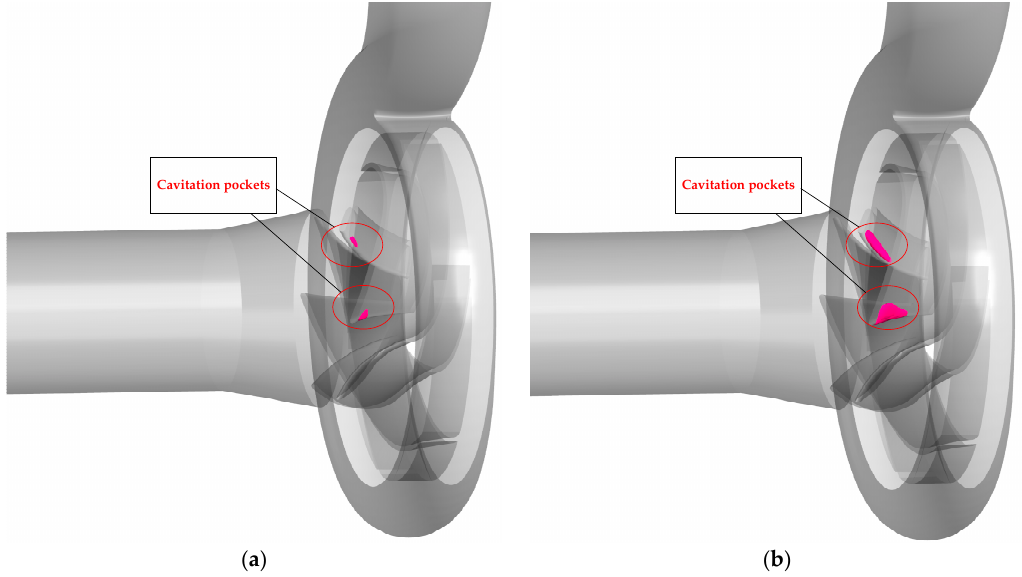
Figure 9. The distributions of cavitation pockets under different flow rates. ( a) 62 m 3 /h, 1.22 Q d ; ( b) 67 m 3 /h, 1.32 Q d . ( b ) 67 m 3 / h, 1.32 Q d